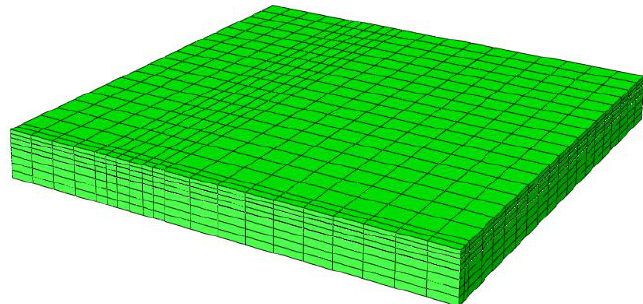
Figure 4. The meshing of 1/4 three-dimensional FE model. Table 1. Properties of bridge deck pavement layers.